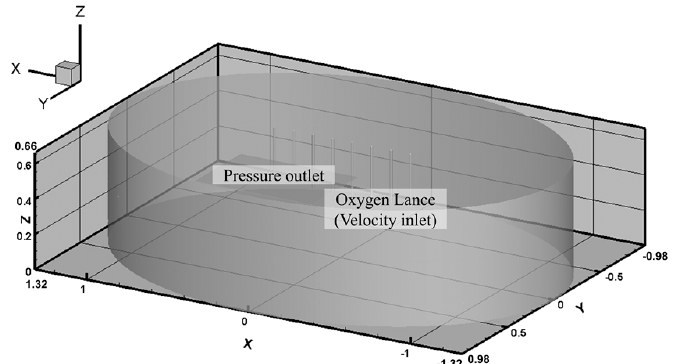
Figure 1. Furnace design.